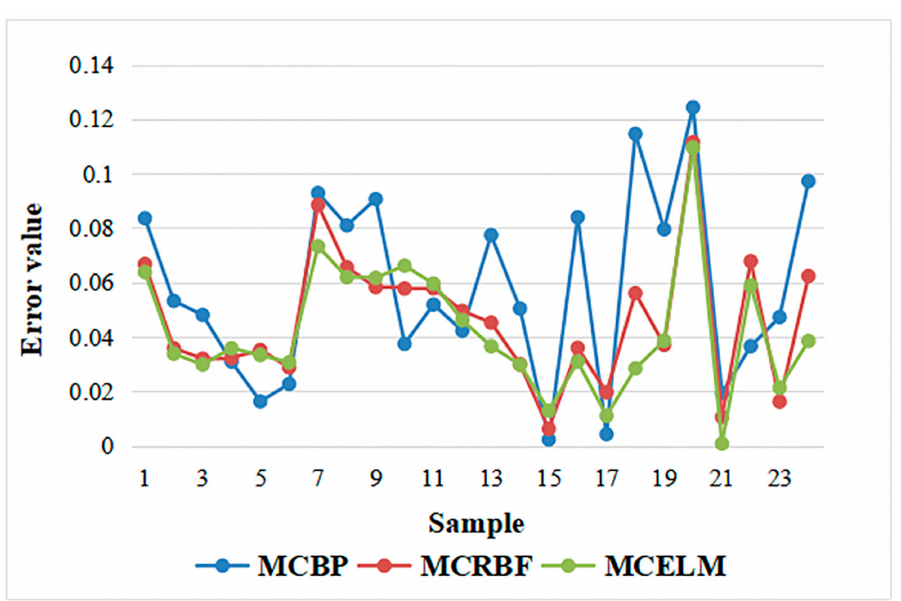
Figure 7. Prediction error comparison of the MCBP, the MCRBF, and the MCELM with 10 nodes. It can be seen from Figure 7 that, when the number of hidden layer nodes is 10, each model performs better than 15 hidden layer nodes and is relatively stable. Finally, reduce the number of hidden layer nodes to 5, and the error prediction comparison chart is shown as Figure 8.